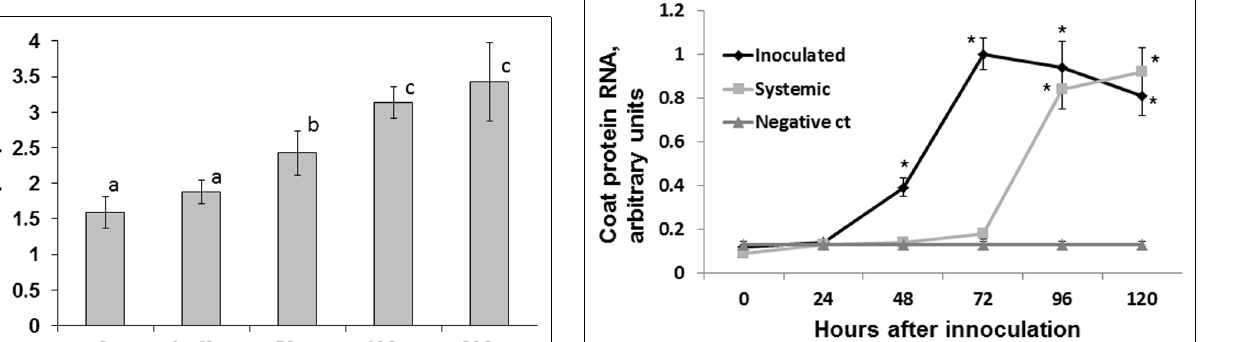
FIGURE 1 |An increase in HRF in systemic tissues of locally infected Arabidopsis plants depends on virus amount used for infection. Plants from line 15d8 were infected at 3 weeks of age, infected leaves were removed at 48 hpi, and HRF was analyzed one week later. “Ct” – non-infected plants. “Buffer” – buffer-treated plants. “50 ng”, “100 ng”, “200 ng” – plants infected with 50, 100, or 200 ng ORMV, respectively.The data are shown as the average number of recombination events per plant with SE calculated from three independent repetitions (20 plants in each experimental group).The letters indicate significantly different values ( P < 0.05); similar letters indicate statistically similar values.